Question: Describe this figure in one sentence.
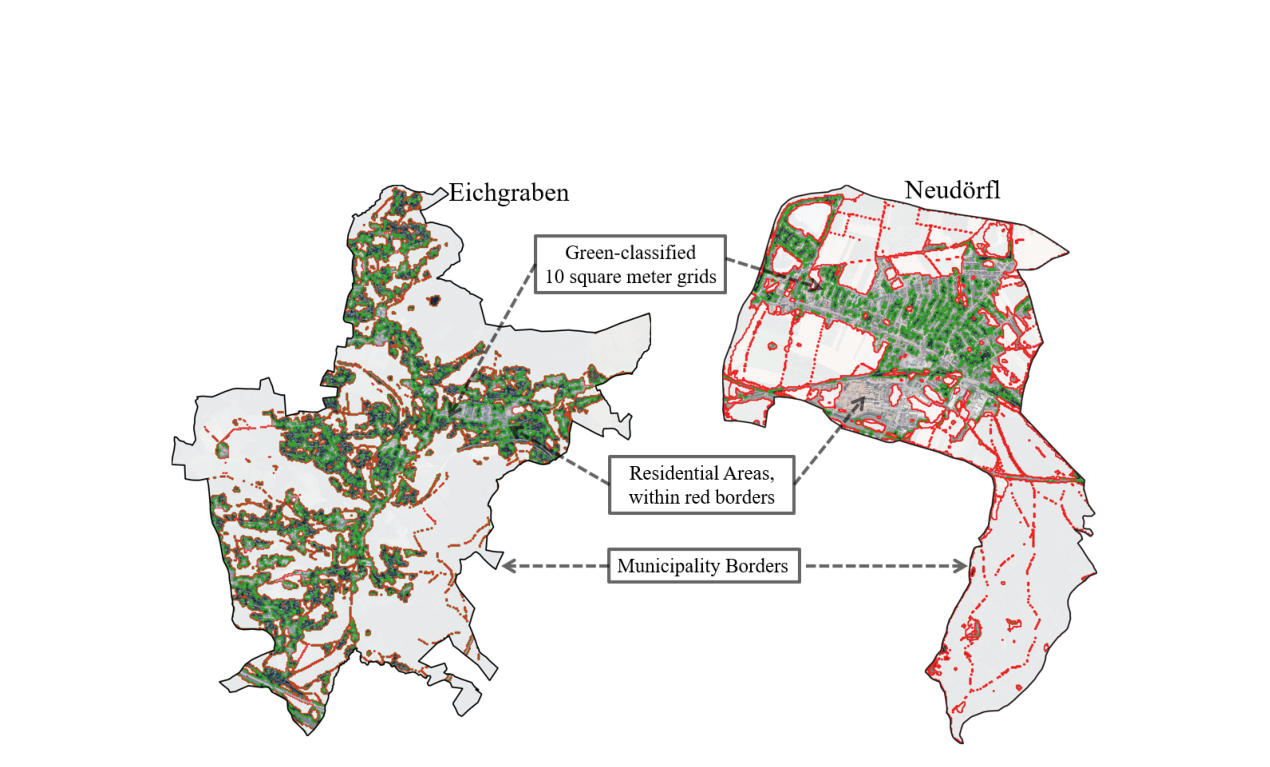
Answer: Comparing the greenness of two Austrian municipalities in 2020, on the left, Eichgraben from Niederösterreich, and on the right, Neudörfl from Burgenland. Both have similar total areas, residential areas, and similar population sizes. However, regarding the greenness of the municipalities using the RGS, Eichgraben has the highest RGS score of all municipalities, while Neudörfl is in the bottom 30% of municipalities ranked by RGS.